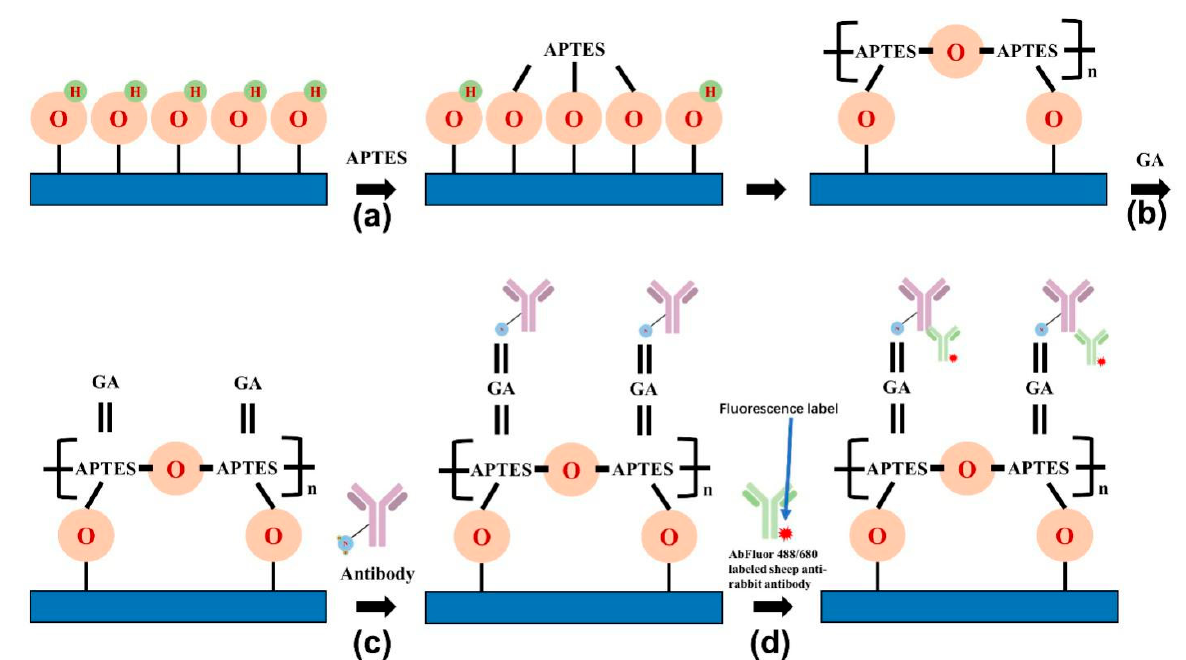
Figure 3. The principle of the saturated fluorescence experiments: ( a , b ) Scheme of the surface modifi- cation process for the chip. ( c ) The modified nanoforest structure with rabbit antibody added. ( d ) The antibody combined with the sheep anti-rabbit antibody labeled by AbFluor 680 or AbFluor 488.